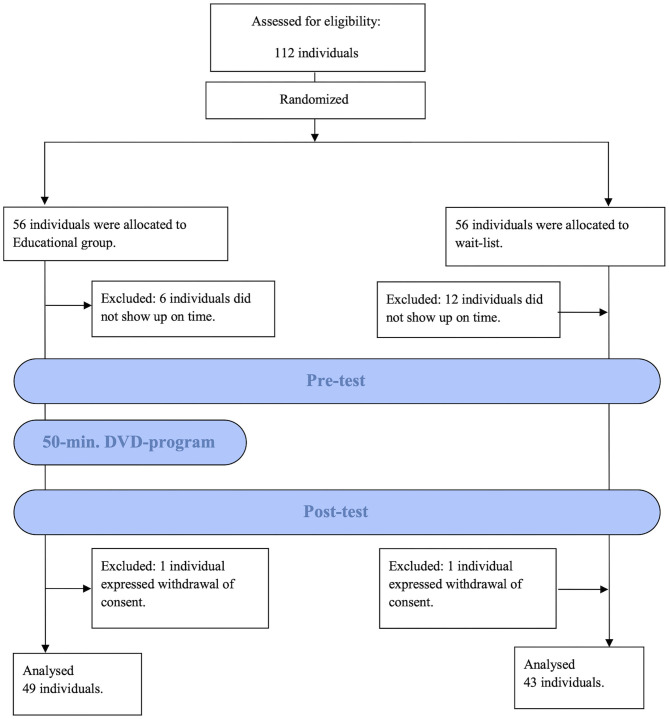
CONSORT flowchart.